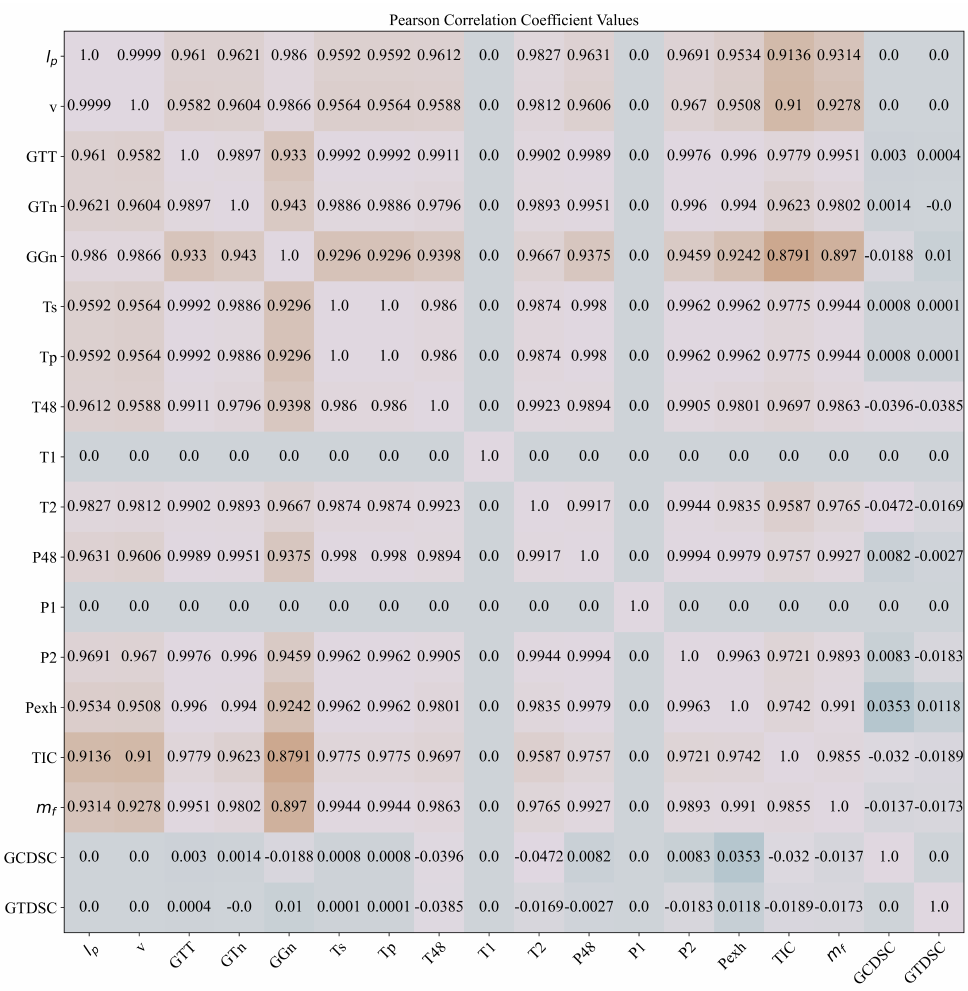
Figure 5. The result of Pearsons correlation